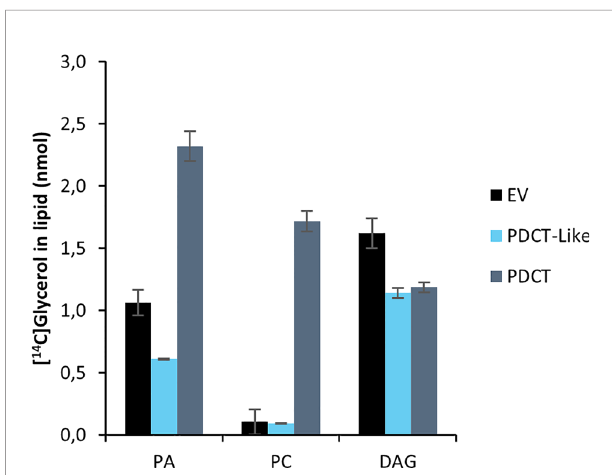
FIGURE 5 | Incorporation of radioactivity into chloroform soluble lipids in microsomal fractions of yeast expressing in the in fi gure indicated C. sativa genes fed [ 14 C]glycerol labeled G3P and 18:3-CoA. Incubation time was 60 min. PA, phosphatidic acid; PC, phosphatidylcholine; DAG, diacylglycerol; EV, Empty vector (control); PDCT, PC : DAG cholinephophotransferase. Average value shown ± SD, n = 3